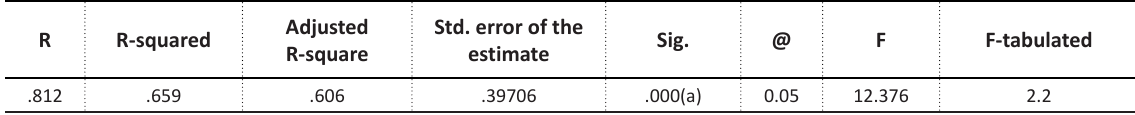
Table 6. The relationship between independent variables and processing of financial bankruptcy from an Islamic perspective